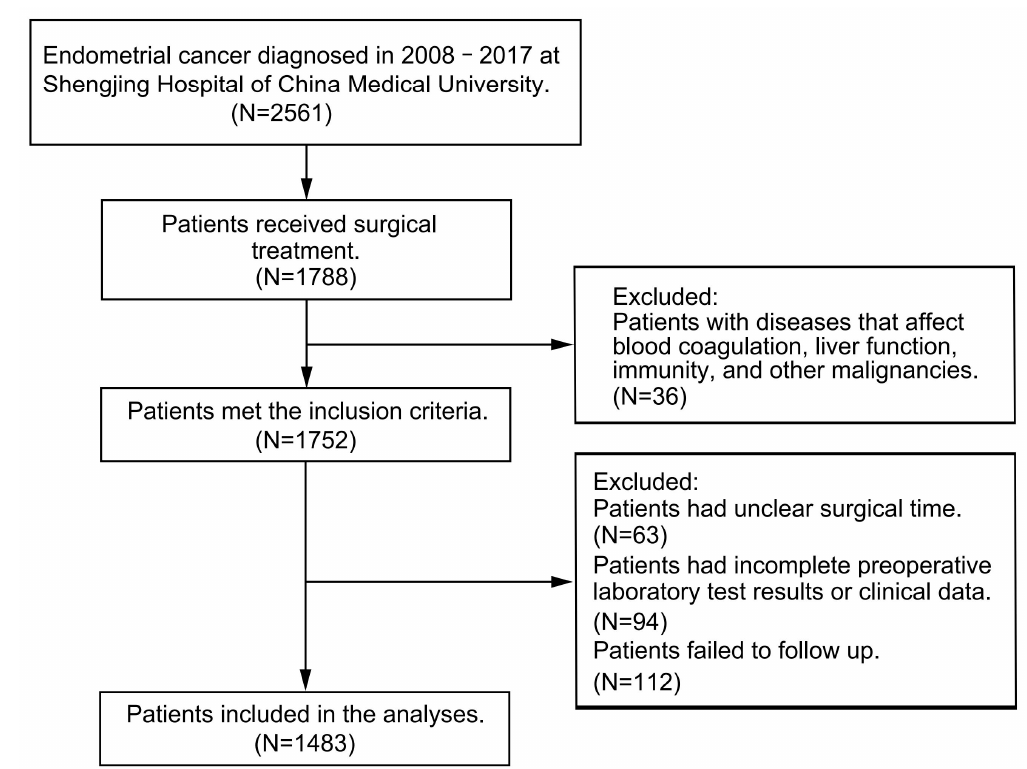
Figure 1. Flow chart of the patient inclusion and exclusion process .